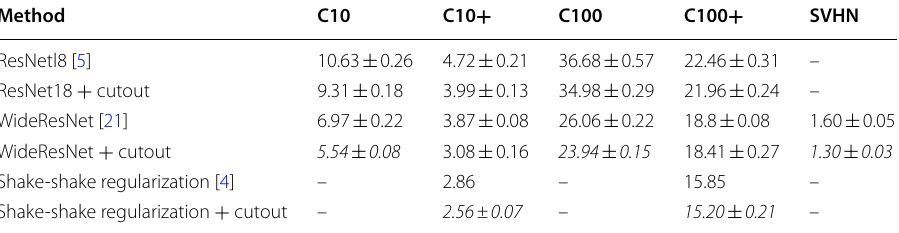
Table 2 Results of Cutout Regularization [104], plus denotes using traditional augmentation methods, horizontal flipping and